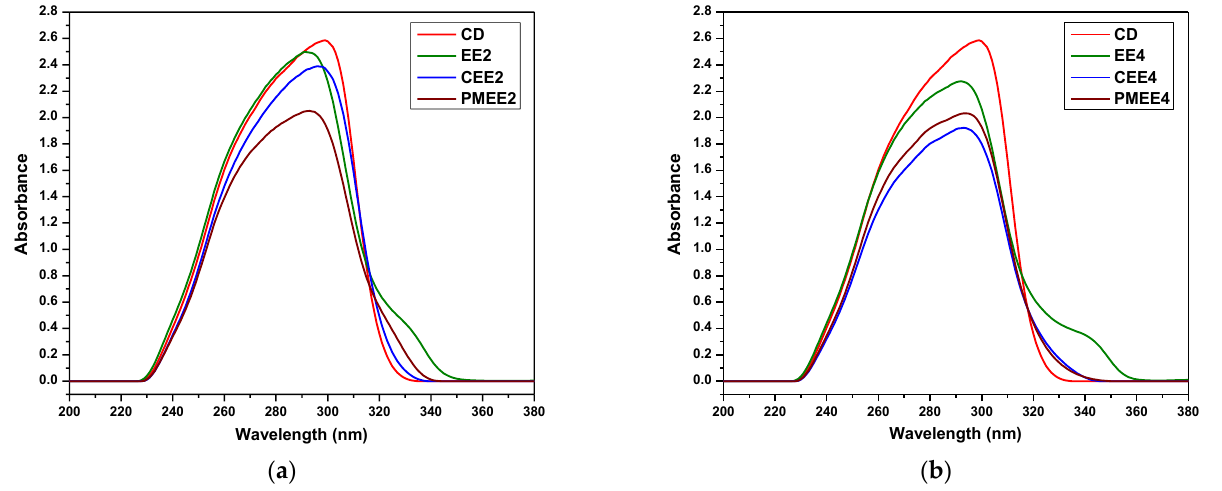
Figure 4. UV-vis spectra of β -cyclodextrin, ethyl ester, inclusion complex, physical mixture: ( a ) ethyl 2-(2-((2-chlorophenyl)carbamoyl)phenoxy)acetate series; ( b ) ethyl 2-(2-((4-chlorophenyl) carbamoyl)phenoxy)acetate series.